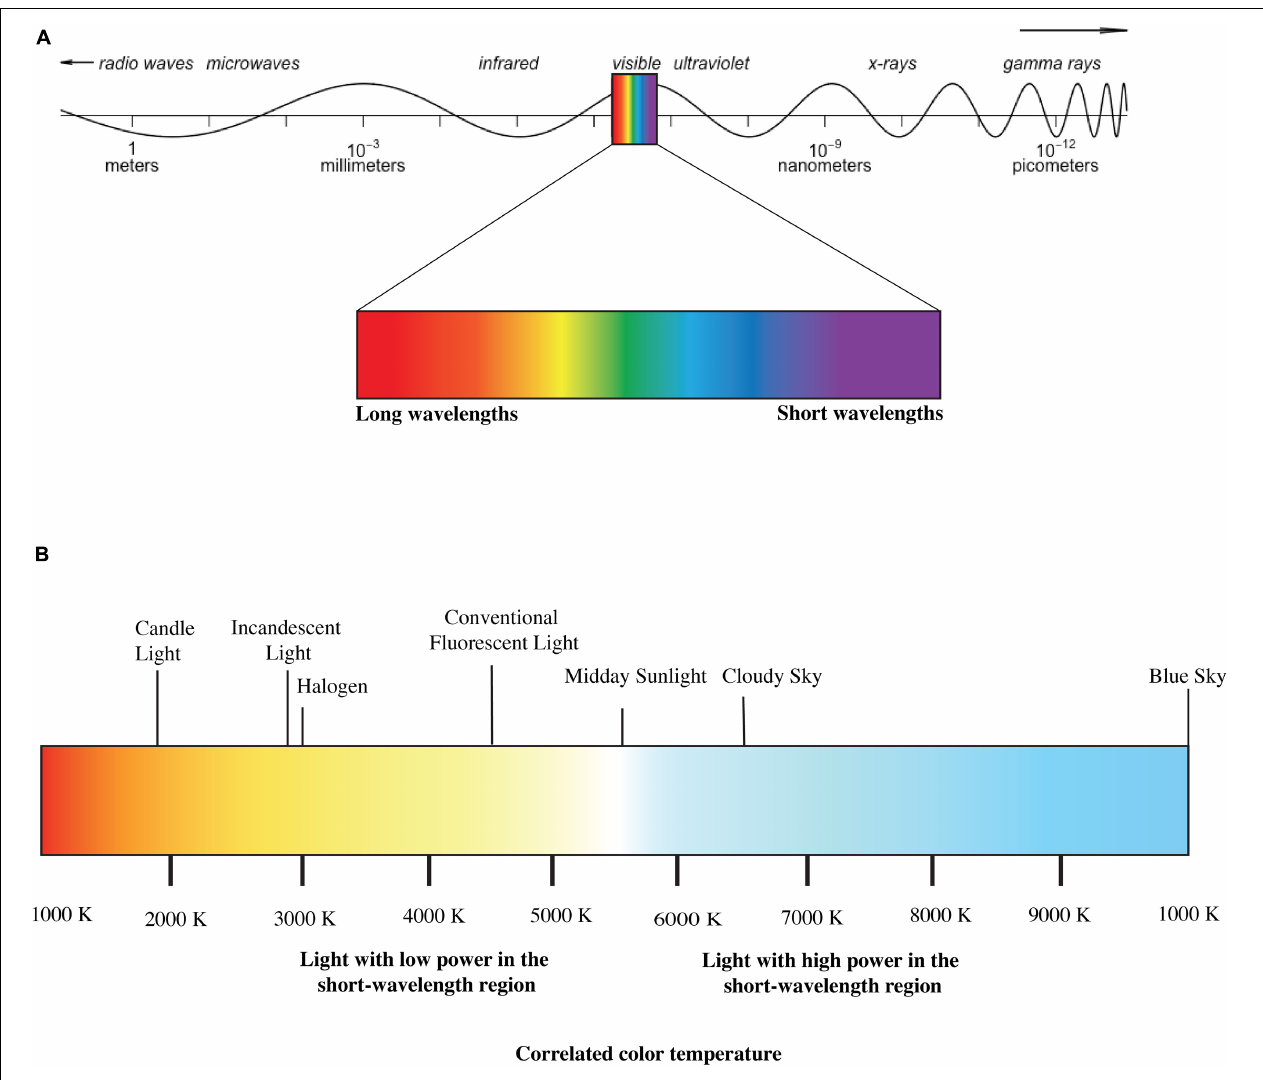
FIGURE 1 | (A) Electromagnetic Spectrum and (B) correlated color temperature (CCT) of lights (disclaimer: figure is for illustration purpose